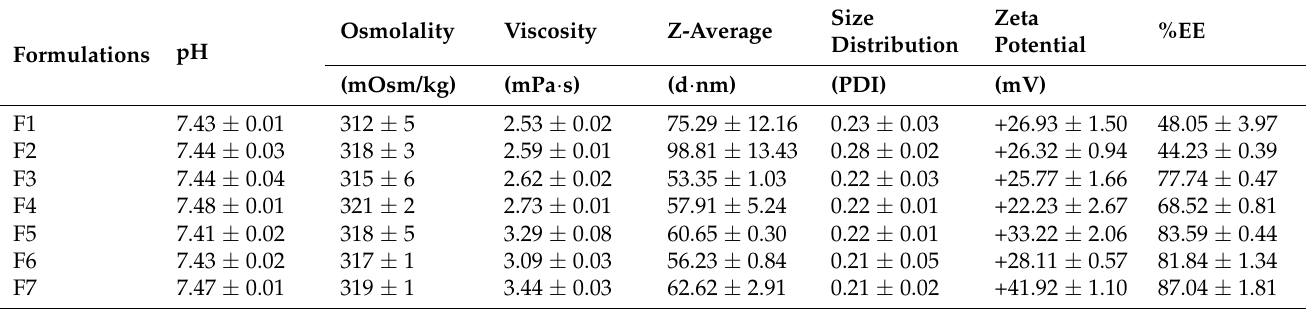
Table 4. Physicochemical and chemical properties of the FE-loaded EuNP eye drop formulations.